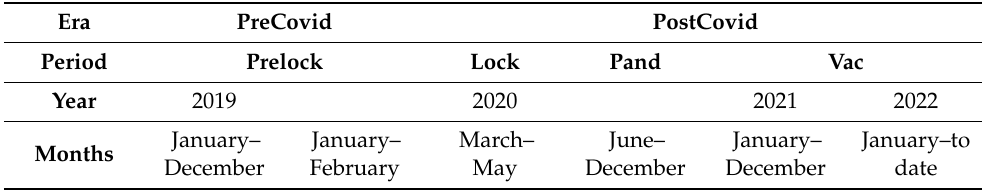
Table 1. Timelapse of the COVID-19